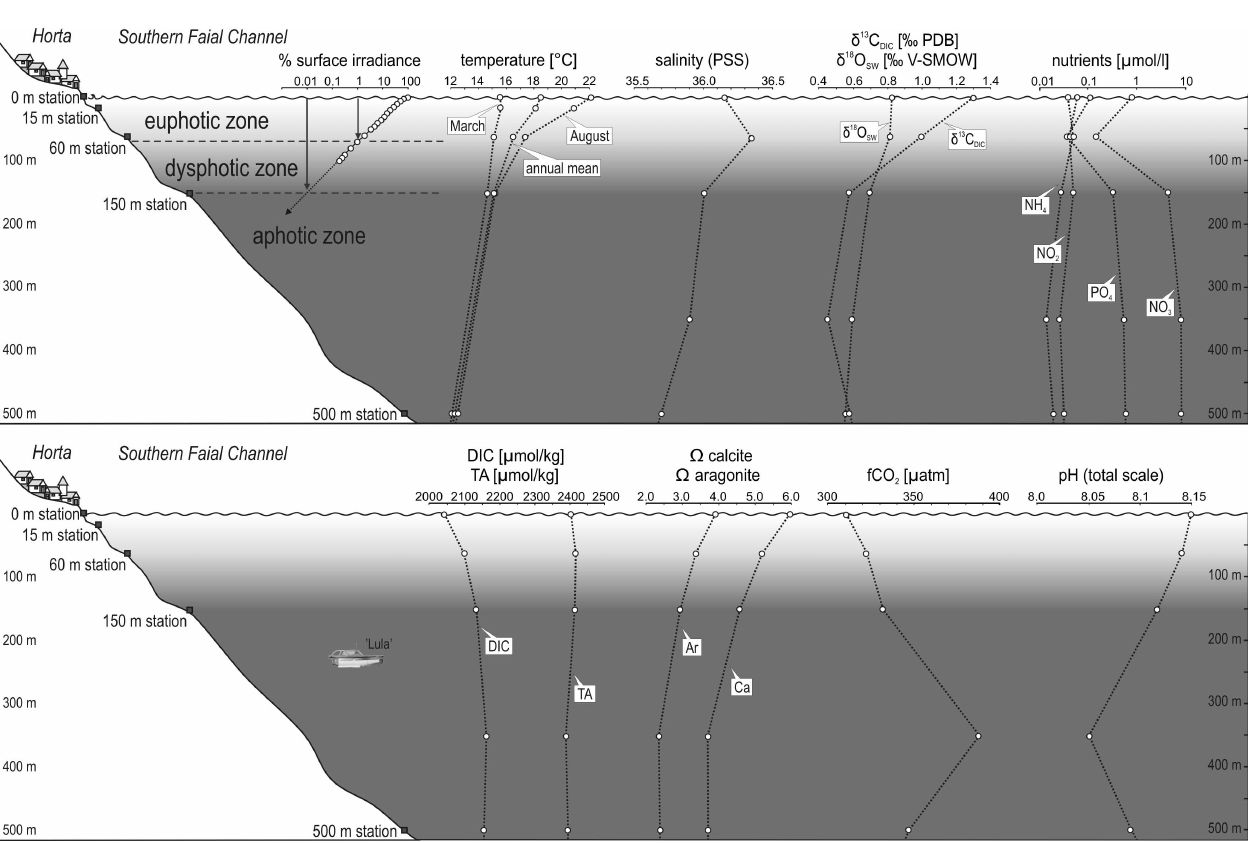
Fig. 5. Schematic bathymetric transect down-slope in the southern Faial Channel with the logged environmental parameters with regard to the light regime, temperature, salinity, stable O and C signature and nutrient regime (top), as well as the measured and computed carbonate system variables, total dissolved inorganic carbon, total alkalinity, saturation states for calcite and aragonite, CO 2 fugacity, and pH